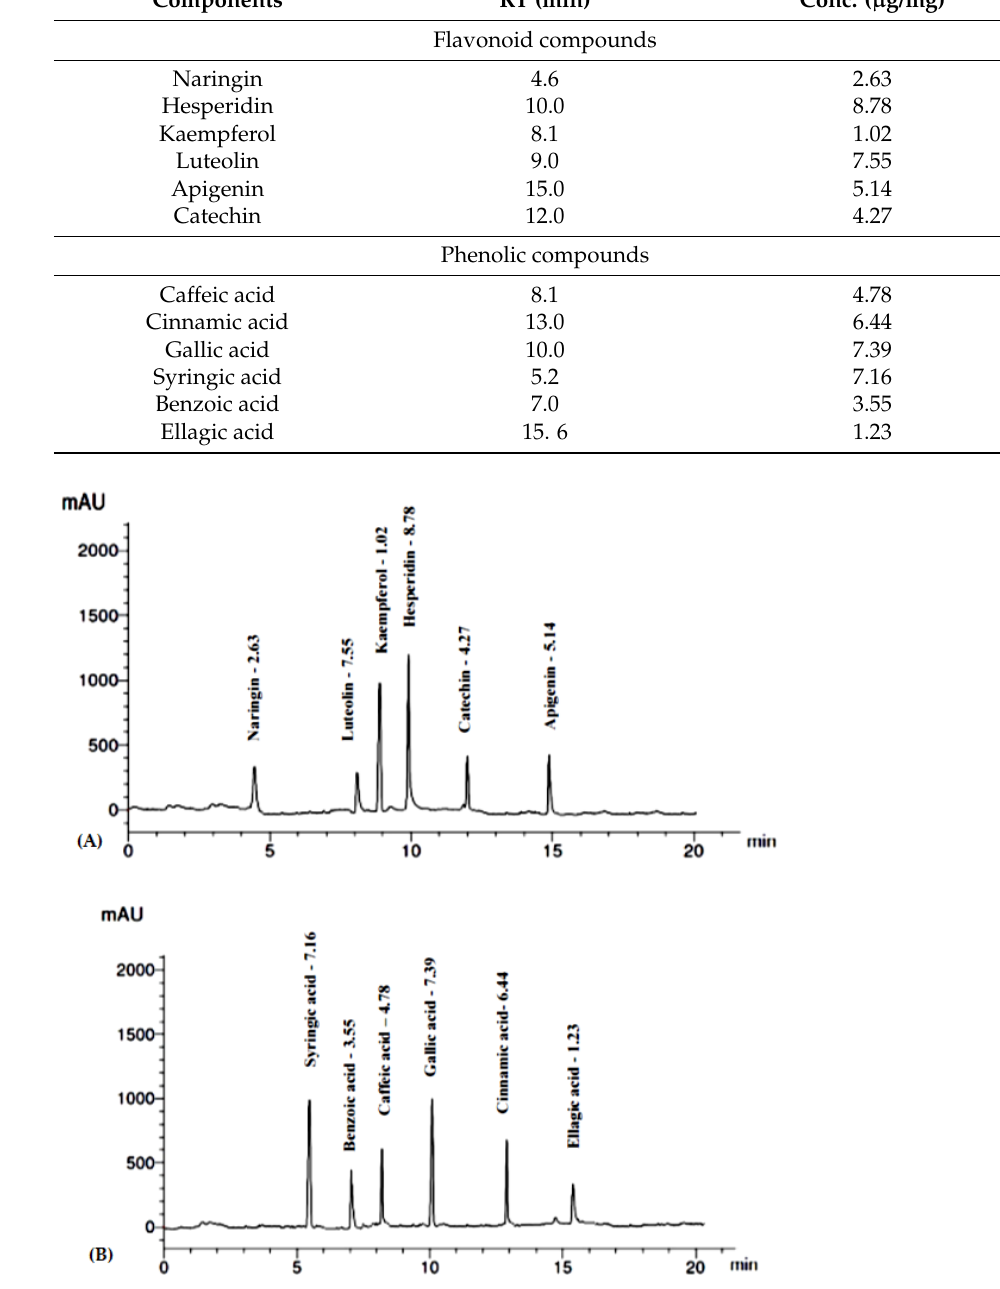
Figure 2. HPLC chromatogram showing identified flavonoids ( A ) and phenolic acids ( B ) in the